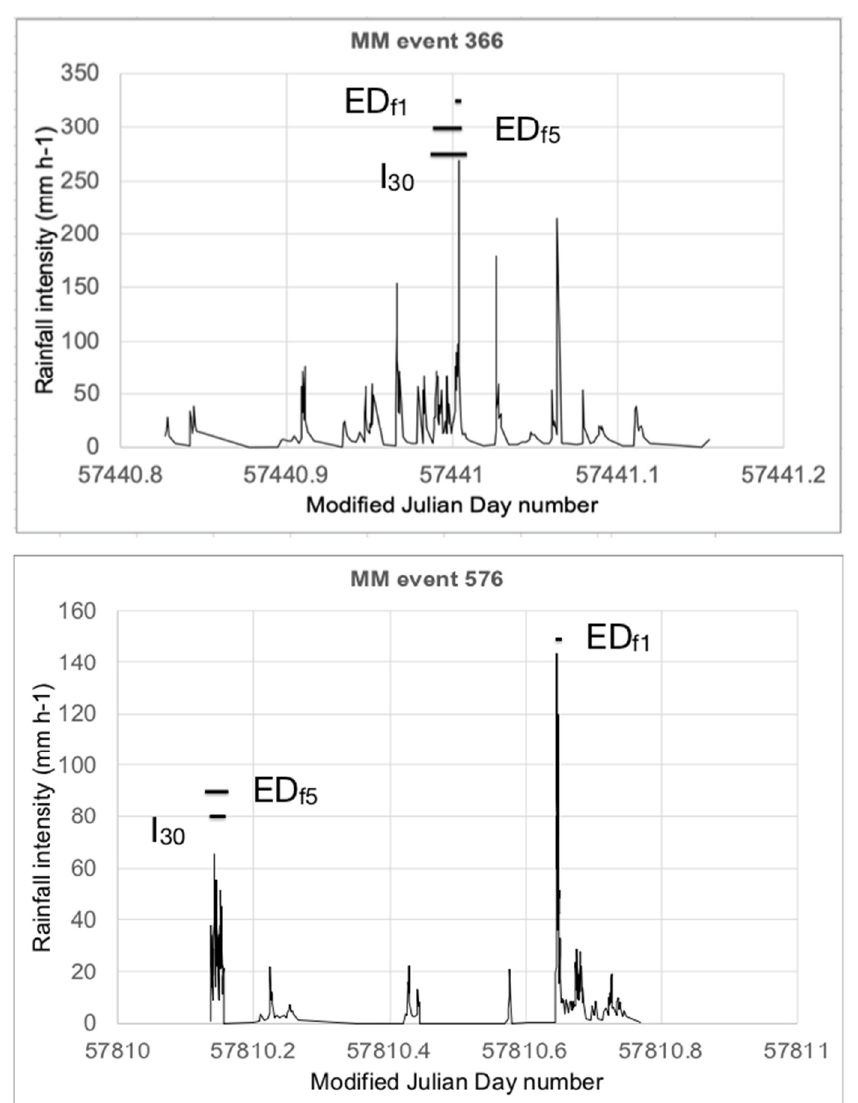
Figure 3. Position of the time intervals of I 30 , ED f1 , and ED f5 in MM rainfall events 366 and 576. Refer to text for details.